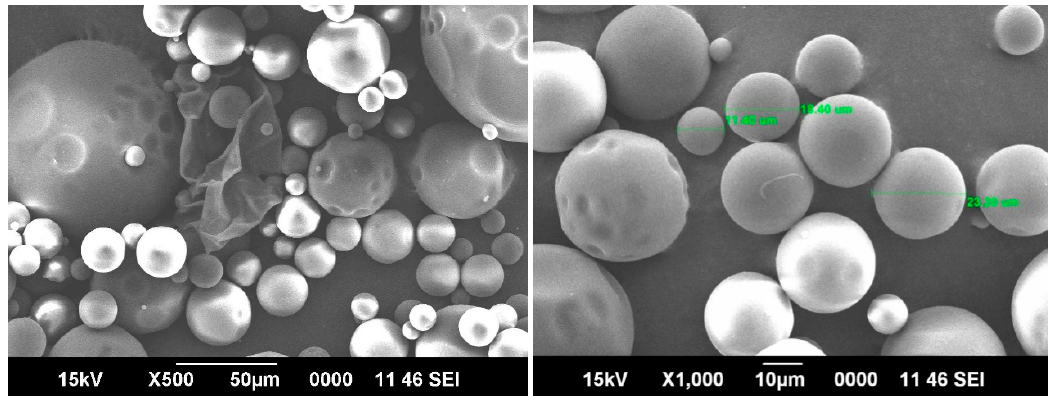
Figure 5. SEM micrographs of 5-FU-loaded blend hydrogel microspheres.